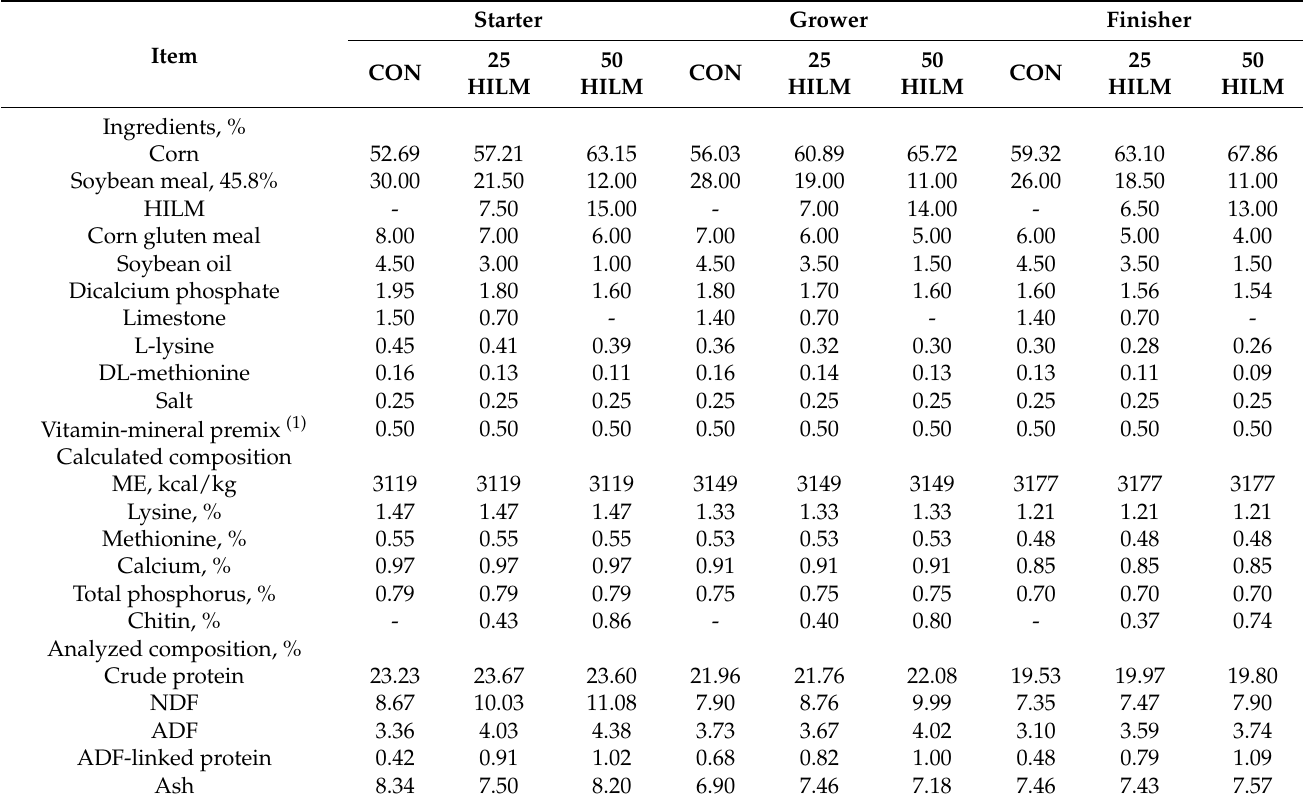
Table 1. Ingredients and chemical composition of the experimental diets (as-fed basis).